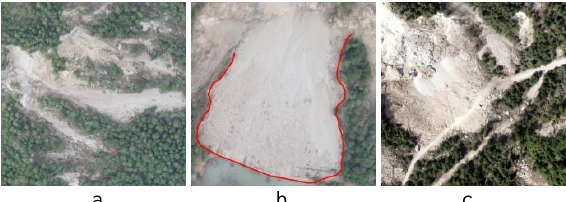
Figure 3. Aerial images of earthquake landslides